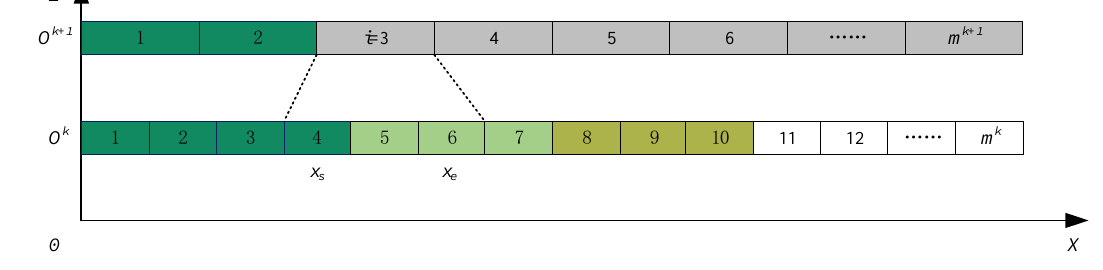
Figure 3. Operating strip state updating.